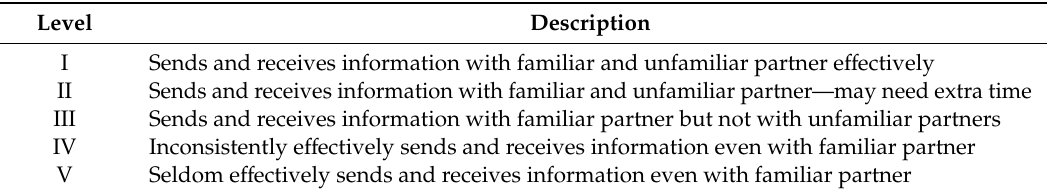
Table 2. The level description of Communication Function Classification System (CFCS).